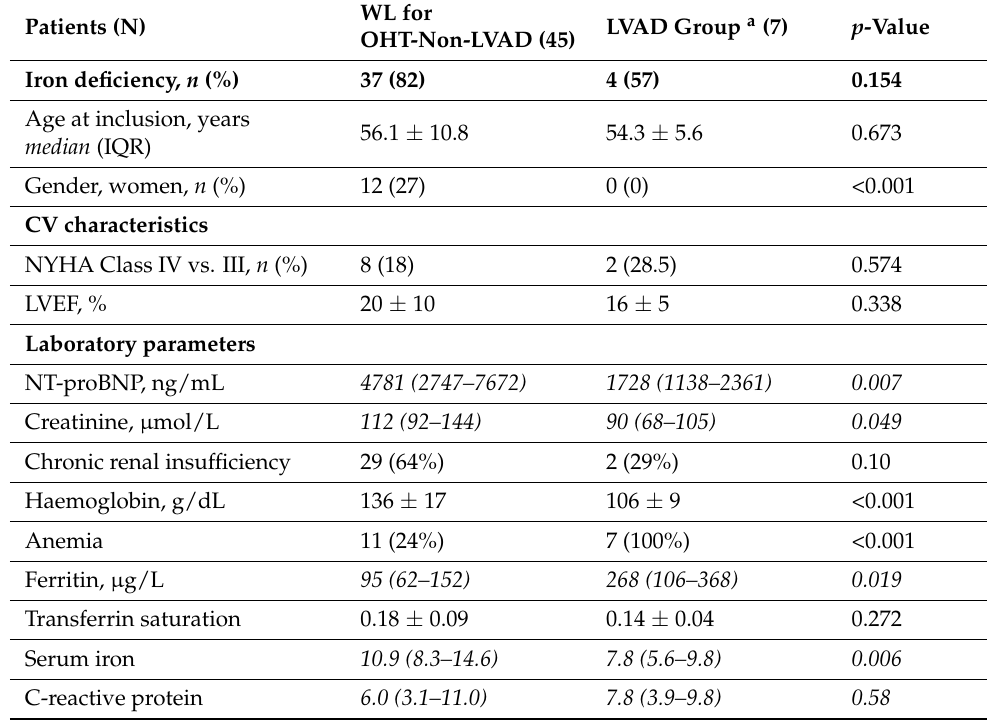
Table 1. Characteristics of patients in the study. WL—waiting list, OHT—orthotopic heart transplan- tation, LVAD—left ventricle assist device, LVEF—left ventricular ejection fraction; NT-proBNP—N- terminal pro-B-type natriuretic peptide; NYHA—New York Heart Association, HF—heart failure. Values of the parameters with normal distribution are presented as mean ± standard deviation, those with different distribution are in italics and shown as median (lower–upper quartile), and binary variables are expressed as number (percentage of total).